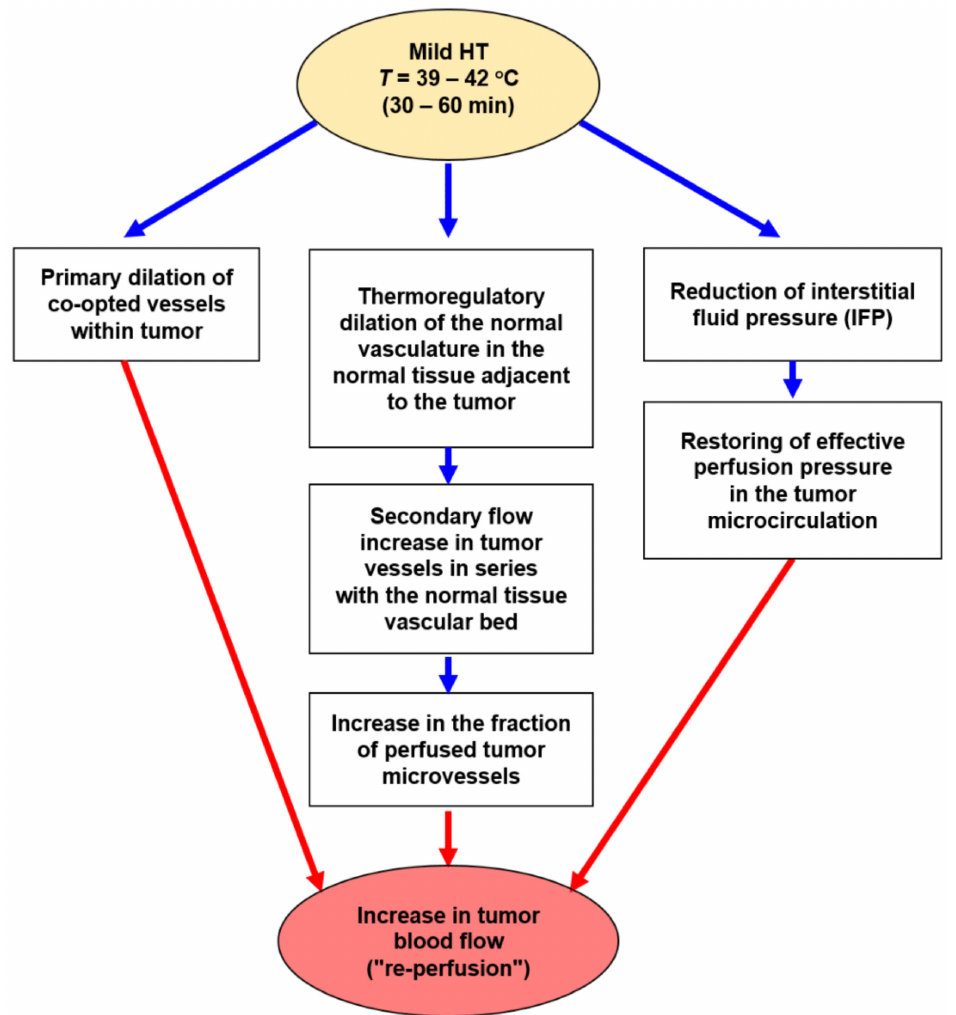
Figure 2. Mild hyperthermia leads to transient increases in tumor blood flow through primary dilation of co-opted pre-existing blood vessels (left pathway) and secondary flow increase (“re-perfusion”) through tumor blood vessels following thermoregulatory “upstream-vasodilation” in the normal tissue adjacent to the “downstream” tumor vessels (central pathway). More sustained improvements may be due to “resumptions” of blood flow due to drastic reduction in interstitial hypertension (i.e., lowering of interstitial fluid pressure, right pathway) and activation of molecular pathways that stimulate VEGF-secretion and thus forced tumor angiogenesis (see Figure 4, left